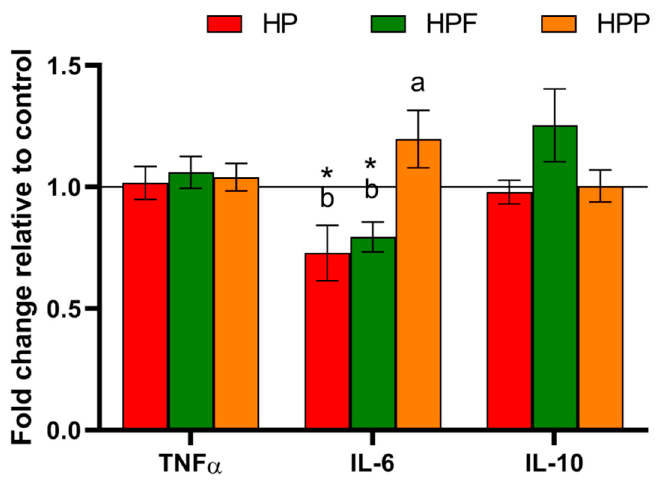
9 of 14 Figure 1. mRNA expression of selected factors associated with lipid metabolism in the livers of rats fed experimental diets. The values are the means ± SEMs. a,b Mean values not sharing the same superscript letter (a or b) are different at p < 0.05 in a post hoc test (Dunn’s test). * Mean values are